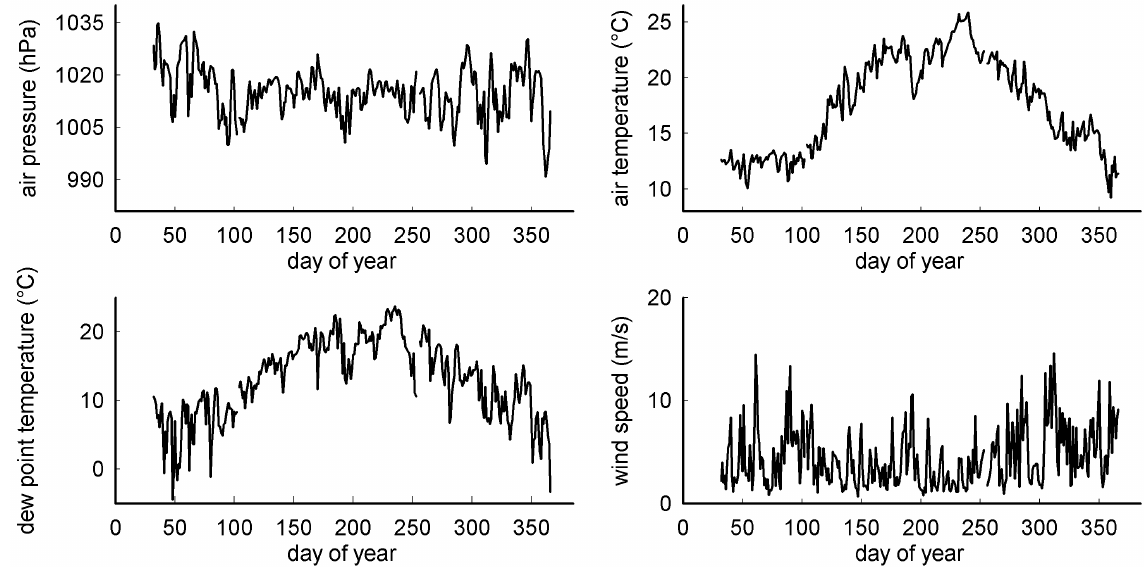
Fig. 3. Time series of near-surface meteorological observables measured at the ODAS Italia 1 buoy from 1 February to 31 December 2000. Daily averages of barometric pressure, air temperature, dew point temperature and wind speed. Table 3. Hourly and daily statistics for the air pressure in terms of mean bias error (MBE) and root mean square error (RMSE). Hourly Values Daily Values MBE (hPa) RMSE (hPa) CC MBE (hPa) RMSE (hPa) CC M2 0.10 0.73 0.98 0.09 0.57 0.99 M5 − 0.05 0.68 0.98 Basin